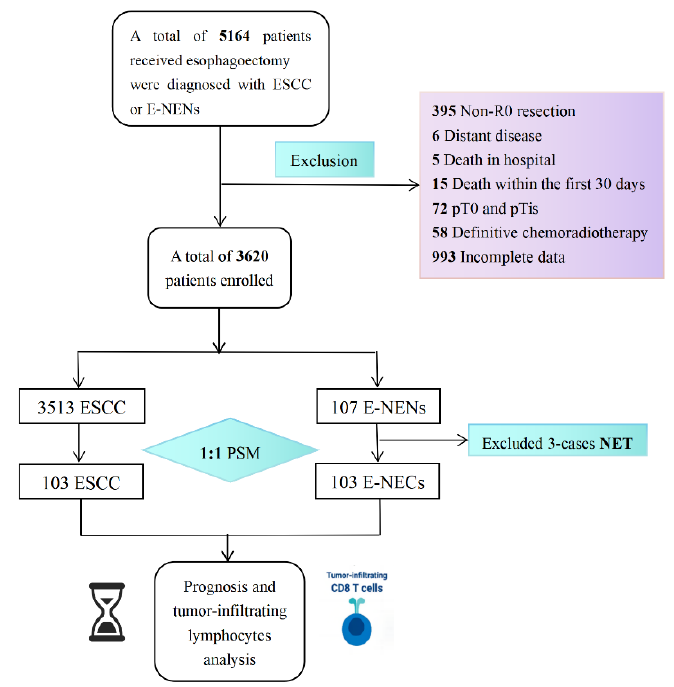
Figure 1. The study flowchart of enrolled population.